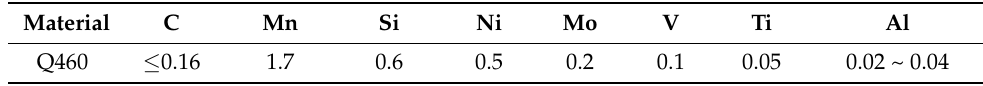
Table 1. Chemical composition of Q460 low-carbon steel (%).